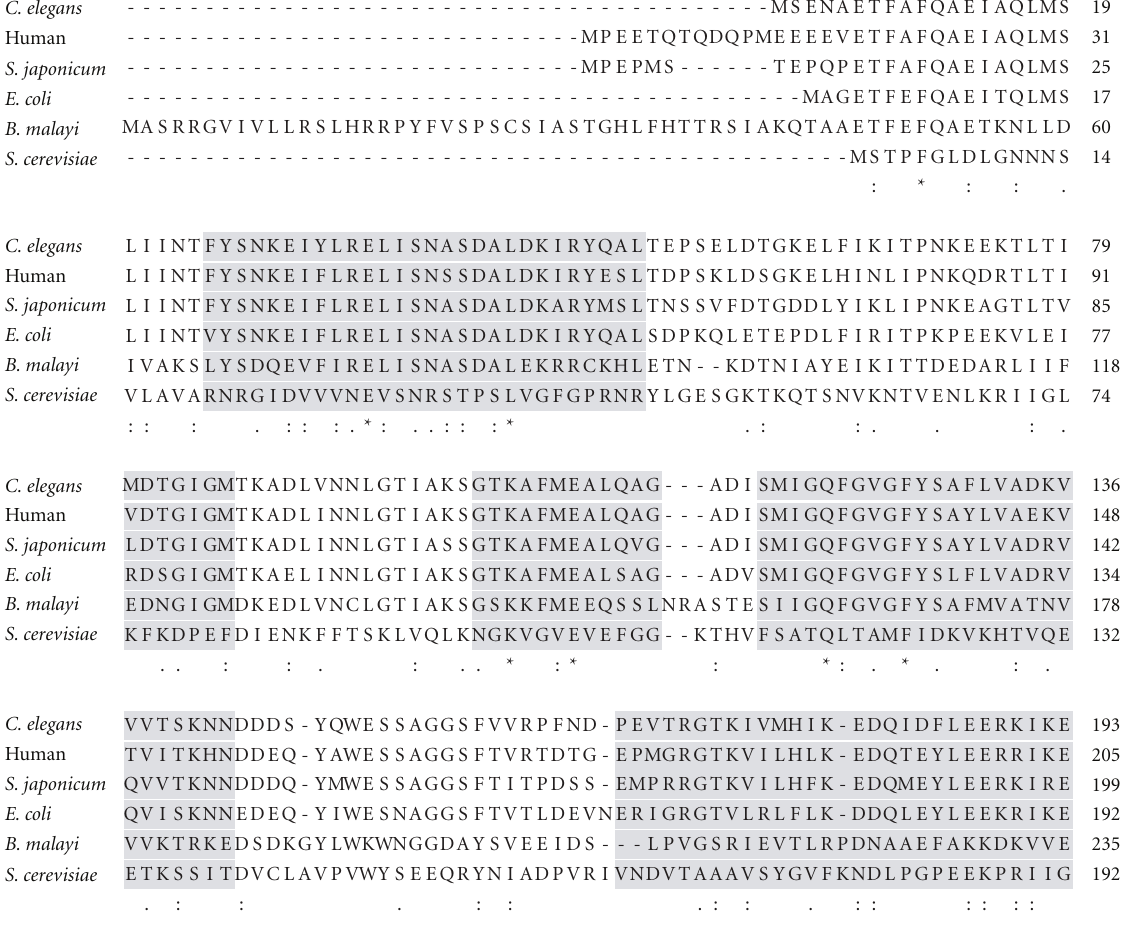
Figure 4: Multiple sequence alignment (Clustal W) of five eukaryotic and one prokaryotic heat shock proteins (Hsp90). Grey-shaded areas indicate residues that comprise the geldanamycin-binding pocket that can be conserved across species [4, 21]. S. cerevesiae : Saccharomyces cerevisiae ; E. coli : Escherichia coli ; S. japonicum : Schistosoma japonicum ; B. malayi : Brugia malayi ; C. elegans : Caenorhabditis elegans